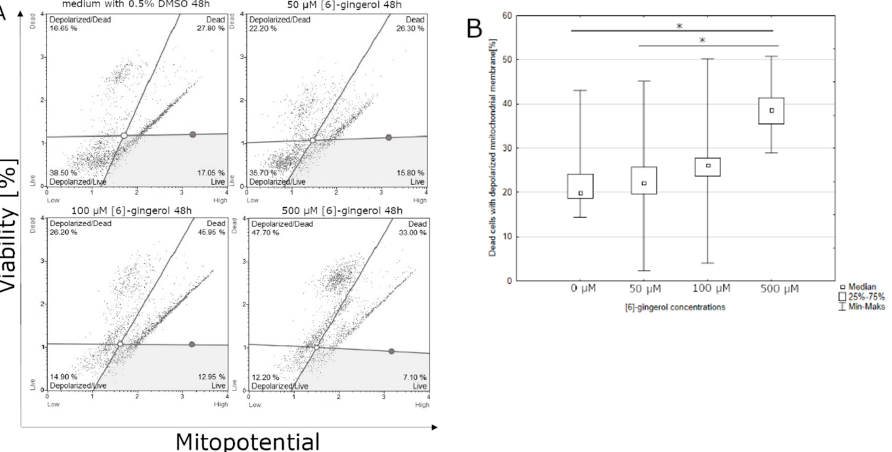
Figure 6. ( A ) [6]-gingerol induces the depolarization of mitochondrial membrane after 48 h incubation using a mitopotential assay. Adherent cells were collected and stained with 7-AAD and then events for depolarized dead cells were counted with the Muse Cell Analyzer; ( B ) assessment of the percentage of dead cells with a depolarized mitochondrial membrane after 48 h incubation depending on the concentration of [6]-gingerol. Therepresentativeexperimentisamedianandadifferencebetween[6]-gingerolconcentration and the control evaluated using ANOVA Friedman p = 0.013 and post-hoc tests * p <